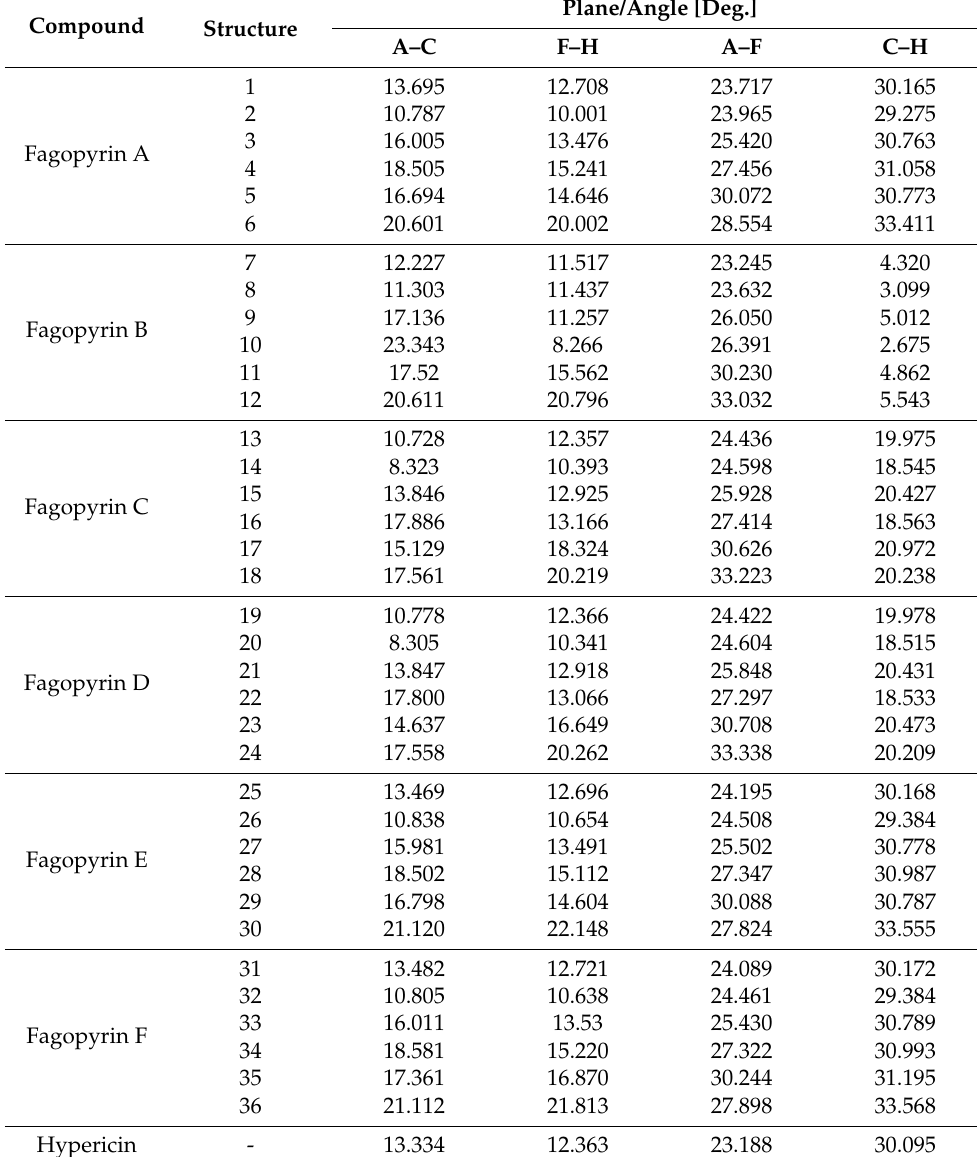
Table 1. Angles between the ring planes in fagopyrin and hypericin conformers. σ = 0.001